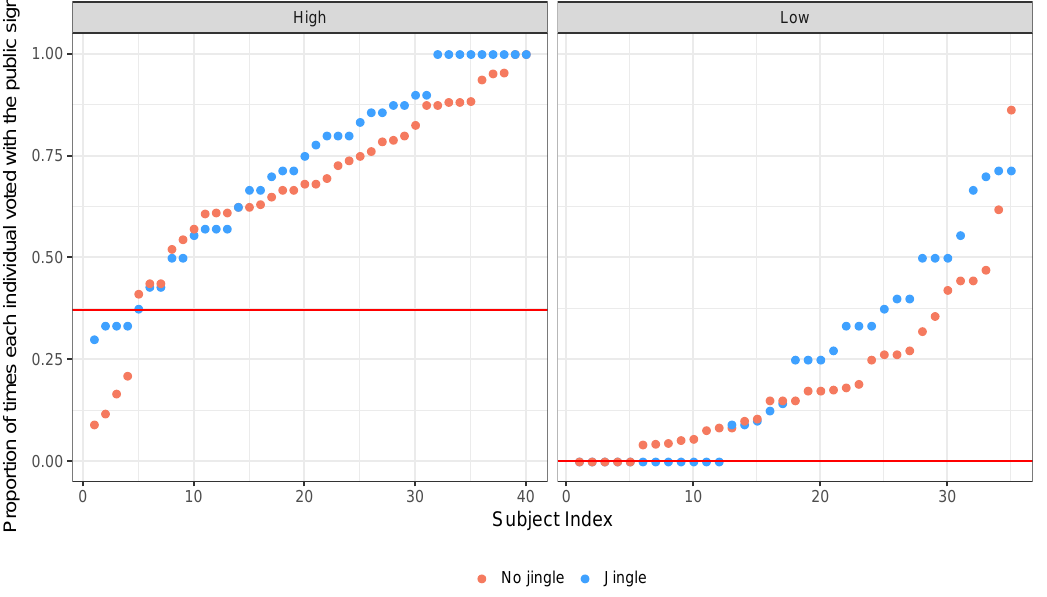
Figure A7. Jingle effect (group sessions). Proportion of times each individual voted according to the public signal. The left image plots values for sessions where Q > q , the right one Q < q . Blue dots correspond to the public signal displayed with the jingle.